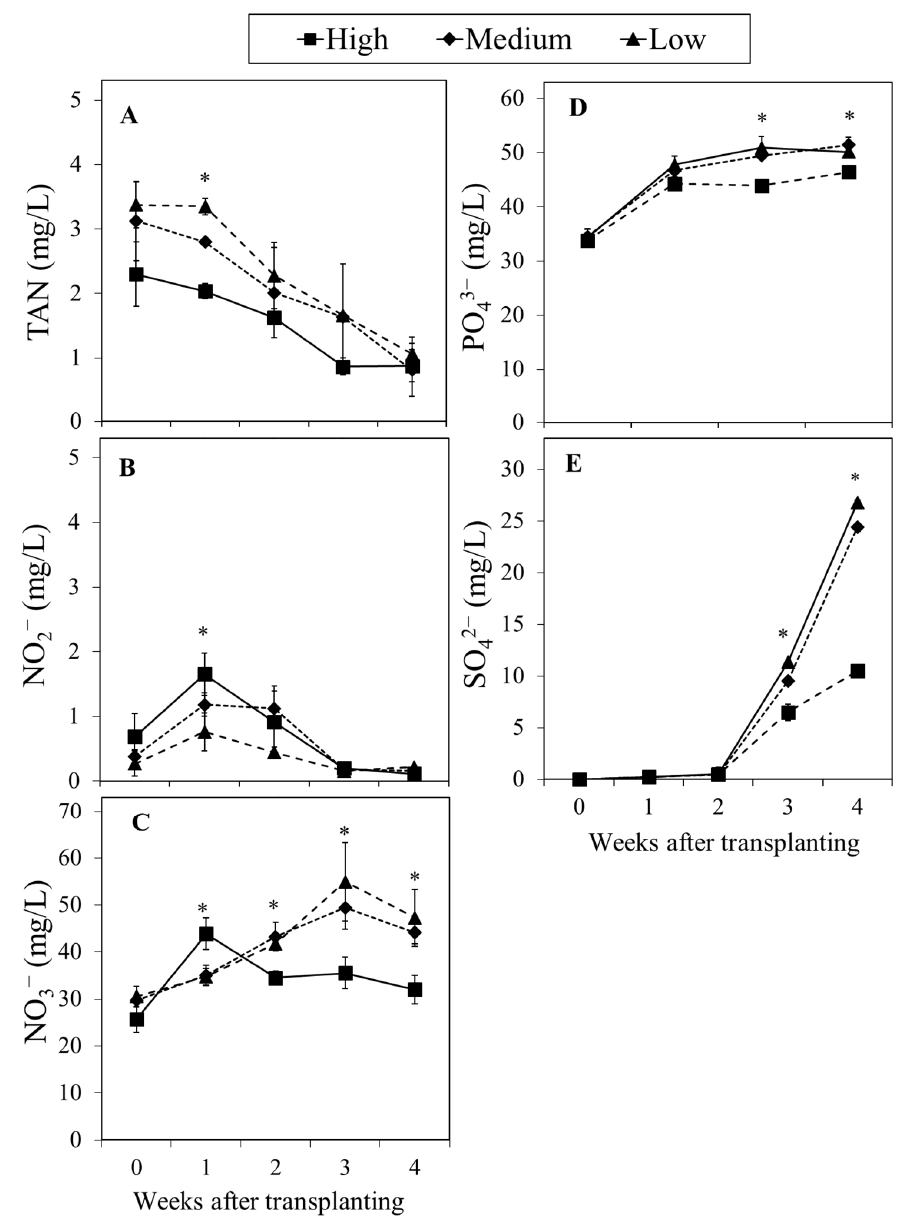
Figure 3. ( A – E ) Dynamic changes in ( A ) total ammonium nitrogen (TAN), ( B ) phosphate (PO 43– ), ( C ) nitrite (NO 2 – ), ( D ) sulphate (SO 4 2– ), and ( E ) nitrate (NO 3 – ) over 4 weeks as affected by high (3.3 m/day), medium (2.2 m/day), and low (1.1 m/day) flow rate treatments. Data were measured every three days and weekly data were combined to show significant differences. Each data point is the mean of 4 replicates ± SE. ns, *, **, *** mean no significant or significant differences at p ≤ 0.05, 0.01, or 0.001, respectively.